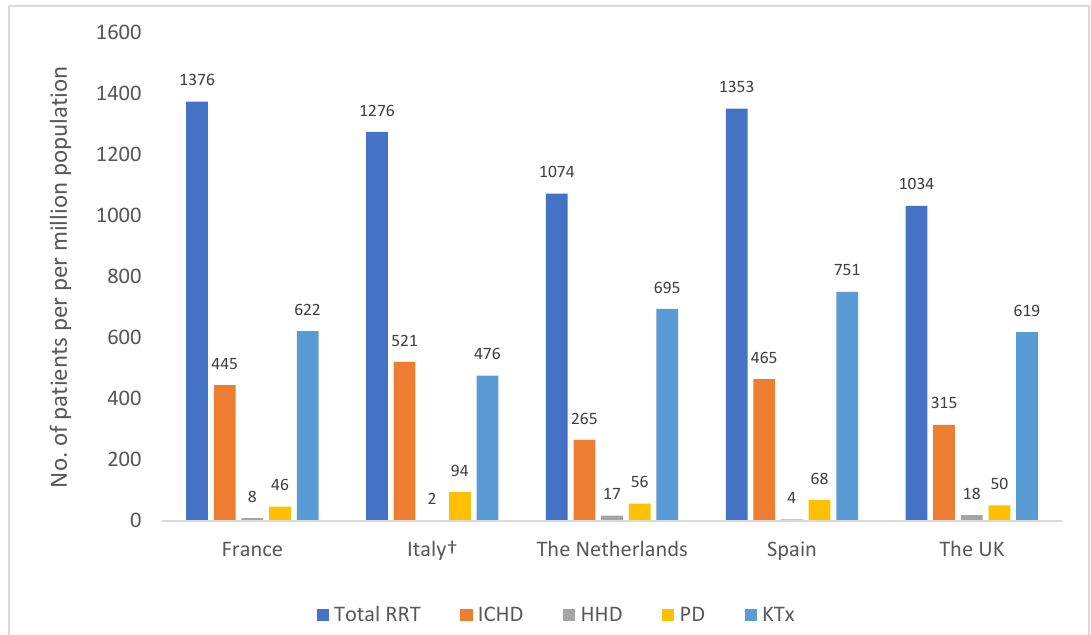
Figure 1. Prevalence of RRT for patients with ESRD by treatment modality (patient per million population). Figure was created using published ERA-EDTA Registry data [45]. Abbreviations: ICHD, in-centre haemodialysis; HHD, home haemodialysis; KTx, kidney transplant; PD, peritoneal dialysis; RRT, renal replacement therapy. † Representative of 8/20 healthcare regions in Italy.